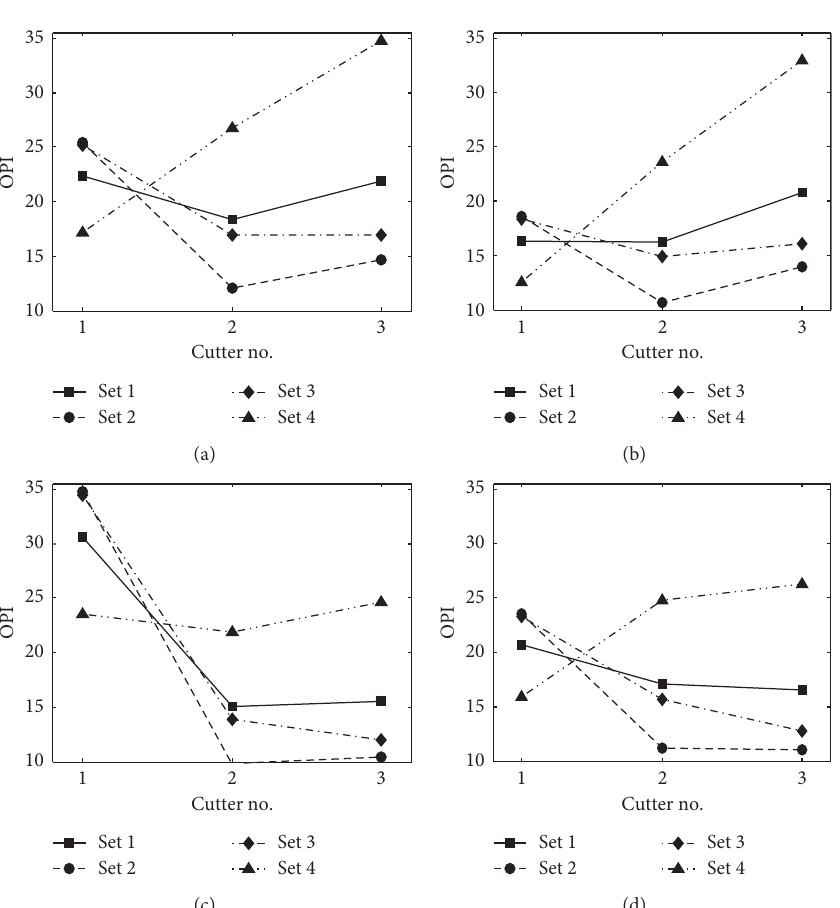
Figure 4: OPIs of the three cutters under different sets of weighting factors of performance parameters. (a) Set I. (b) Set II. (c) Set III. (d) Set